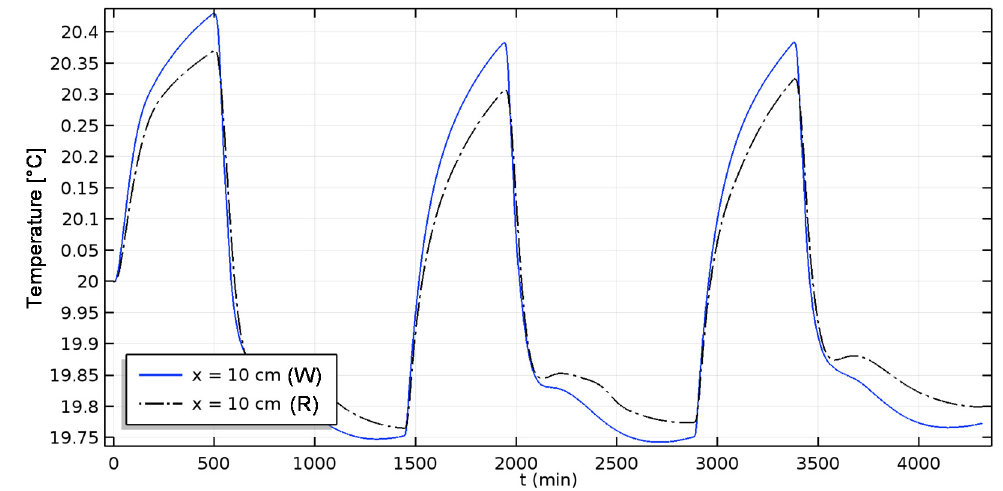
Figure 10. Isothermal case: Temperature evolution of aged and reference hemp concrete (W: Weathered; R: Reference).